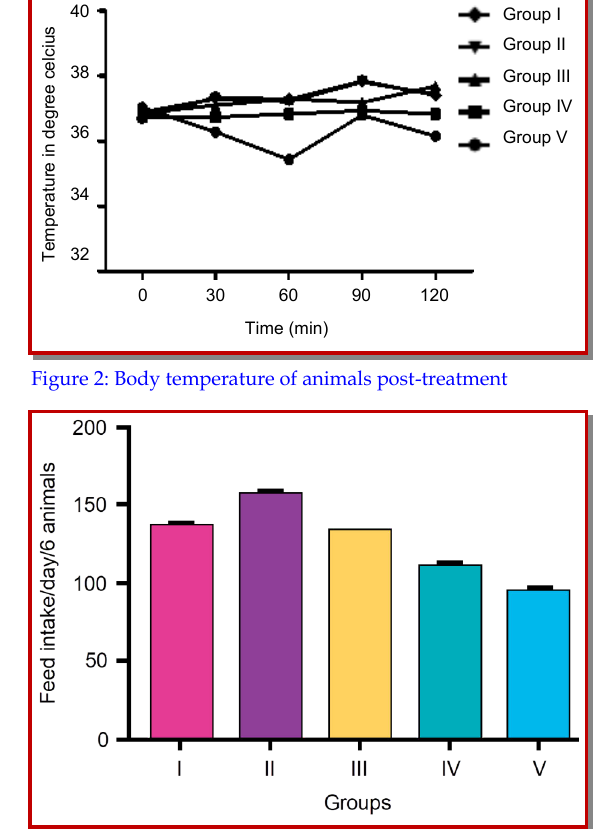
Figure 3: Feed intake per day of animal